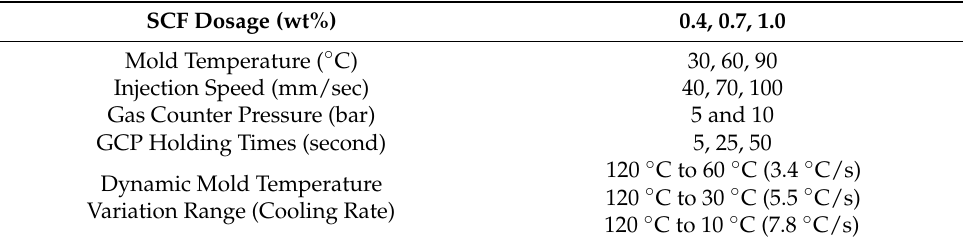
Table 3. Processing parameters (with GCP and/or Table 2. Processing parameters (traditional MuCell ® ).